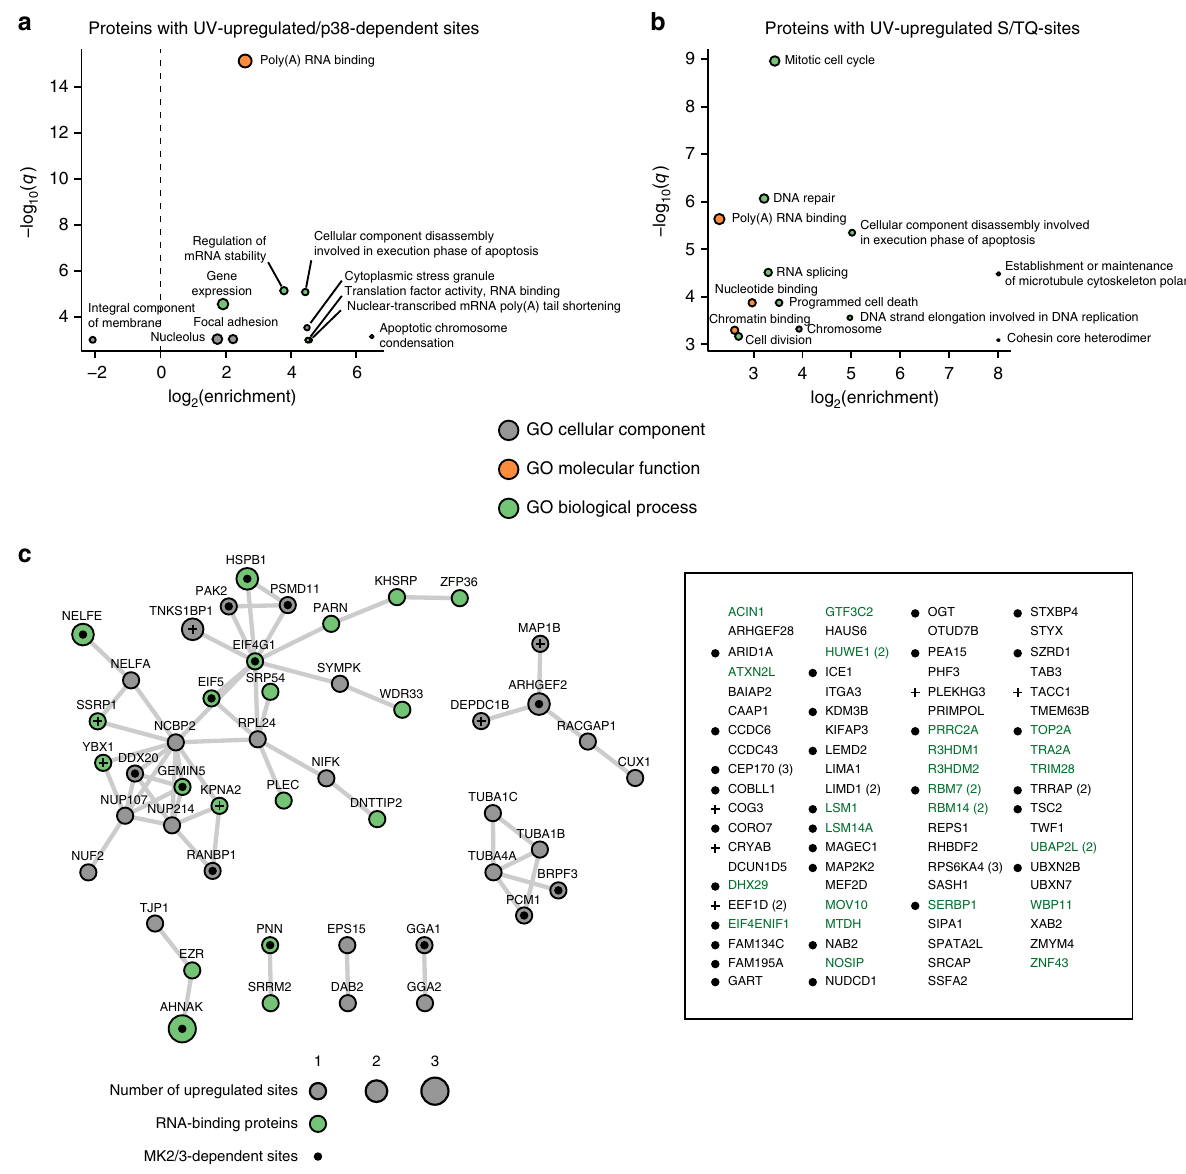
Fig. 3 p38 phosphorylates RNA-binding proteins after UV light. a GO terms signi fi cantly enriched among proteins with UV-light-upregulated, p38- dependent phosphorylation sites. The dot plot shows signi fi cantly enriched GO terms associated with proteins containing p38-dependent phosphorylation sites compared with proteins with non-regulated phosphorylation sites. The signi fi cance of the enrichment of a speci fi c term was determined using Fisher ’ s exact test. P -values were corrected for multiple hypotheses testing using the Benjamini and Hochberg FDR. b GO terms signi fi cantly enriched among proteins with UV-light-upregulated, S/TQ phosphorylation sites. The dot plot shows signi fi cantly overrepresented GO terms associated with proteins containing S/TQ phosphorylation sites compared with proteins with non-regulated phosphorylation sites. The analysis was done as described in Fig. 3a. c Analysis of functional interactions among proteins with UV-light-upregulated, p38-dependent phosphorylation sites. The functional interactions were obtained from the STRING database and visualized using Cytoscape. Proteins with UV-light-upregulated, p38-dependent sites that do not form a functional network are indicated on the right and proteins annotated with “ RNA-binding ” GO-molecular function term are indicated in green. Proteins with MK2/3- dependent phosphorylation sites are indicated with circles and proteins with MK5-dependent sites with